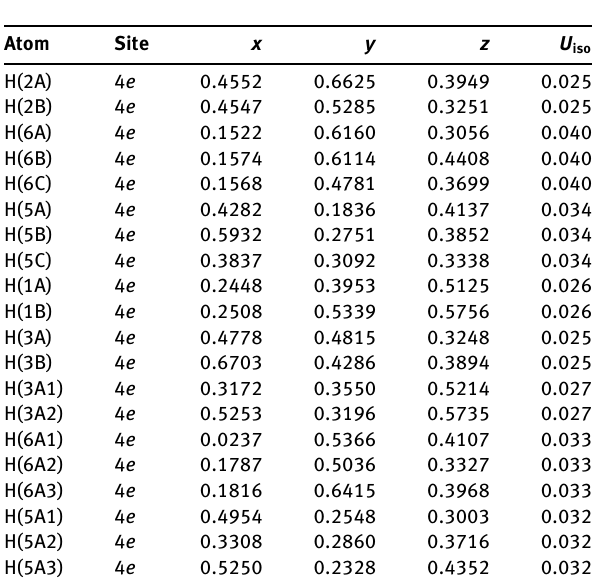
Table 2: Fractional atomic coordinates and isotropic or equivalent isotropic displacement parameters (Å 2